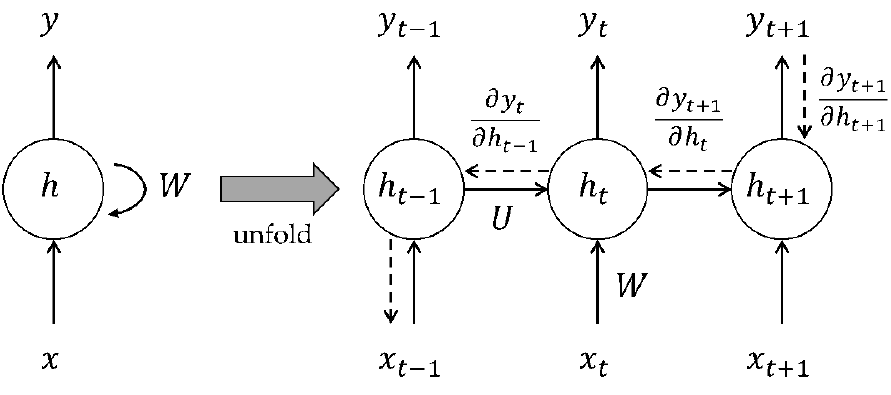
Figure 3. The structure of a recurrent neural